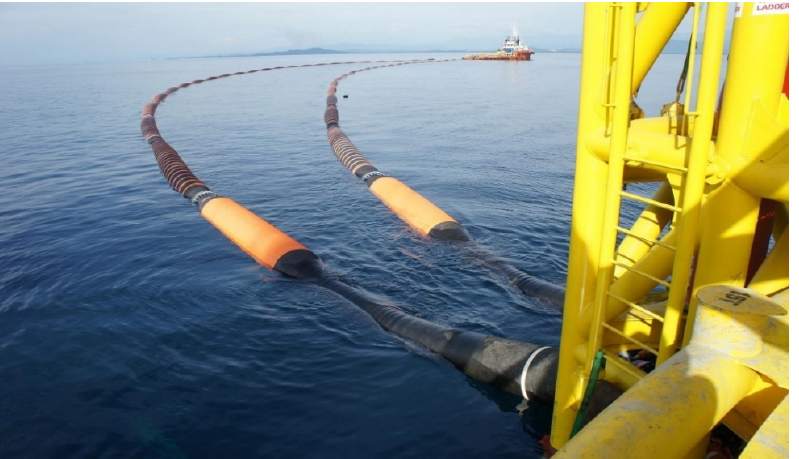
Figure 2. SPM buoy hose system from the buoy to the shuttle tanker on an SPM Terminal (Provided by Trelleborg for this paper, and used with permission, Courtesy: Trelleborg).